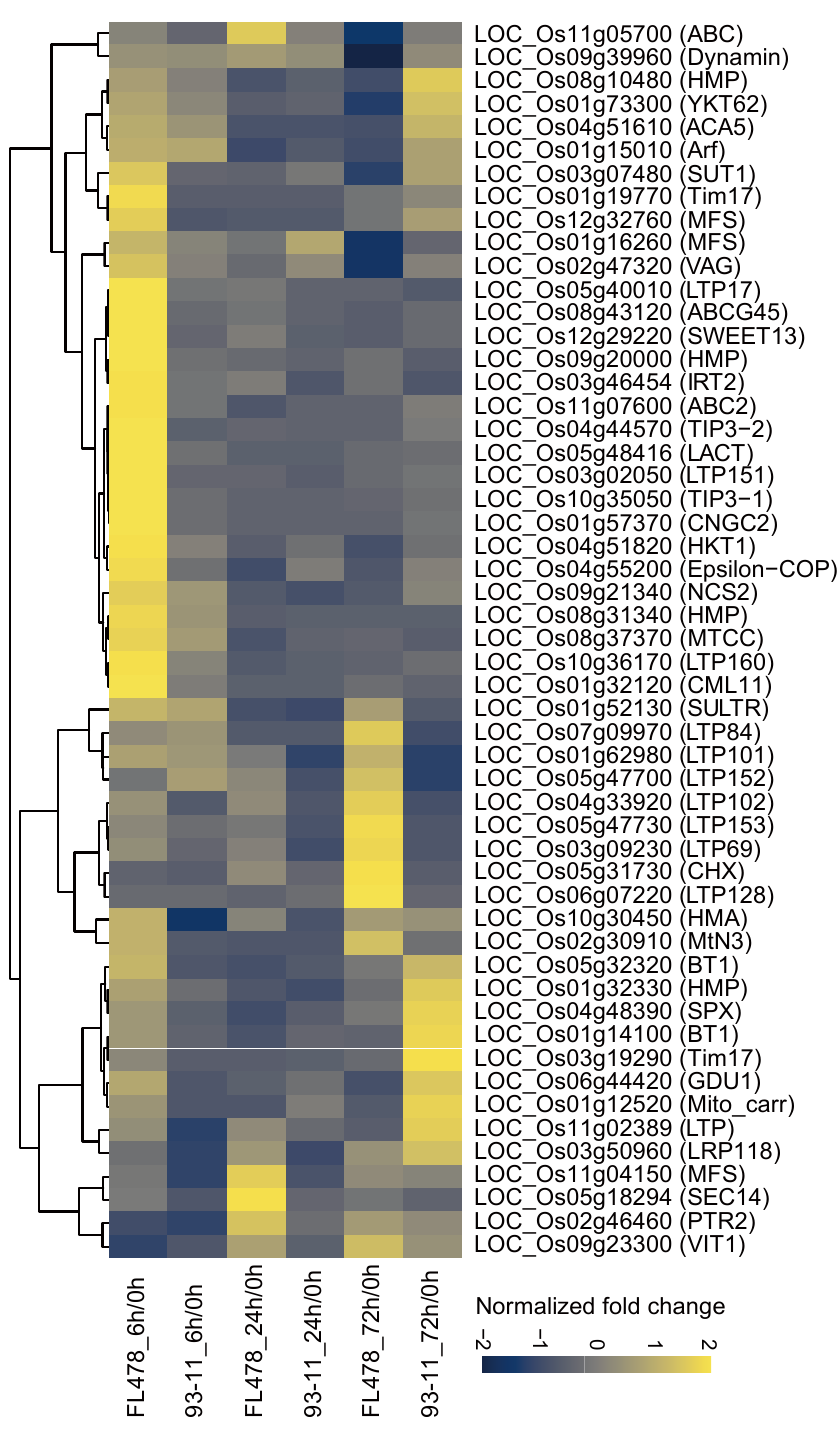
Figure 3. The heatmap of salt tolerance genes related to transporters. The fold-change was centered and scaled in the row direction.